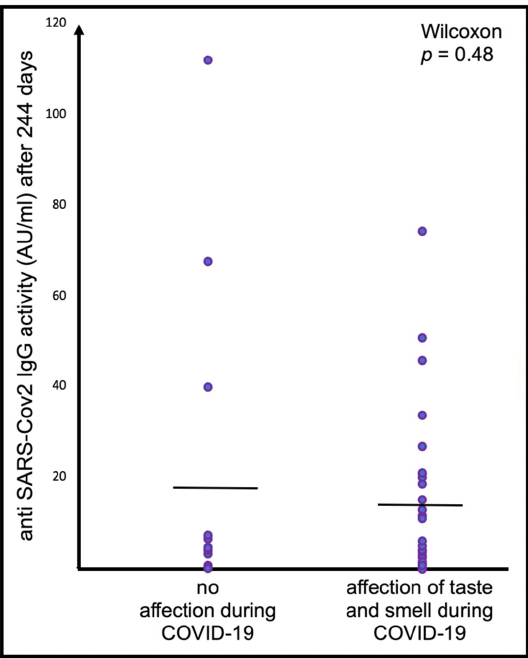
Figure A2. Anti SARS-Cov2 IgG levels after a median of 244 days after positive RT-PCR test of the participants with or without alteration of taste and smell during the illness. Data analysis with the Wilcoxon test showed no significant difference between both groups.